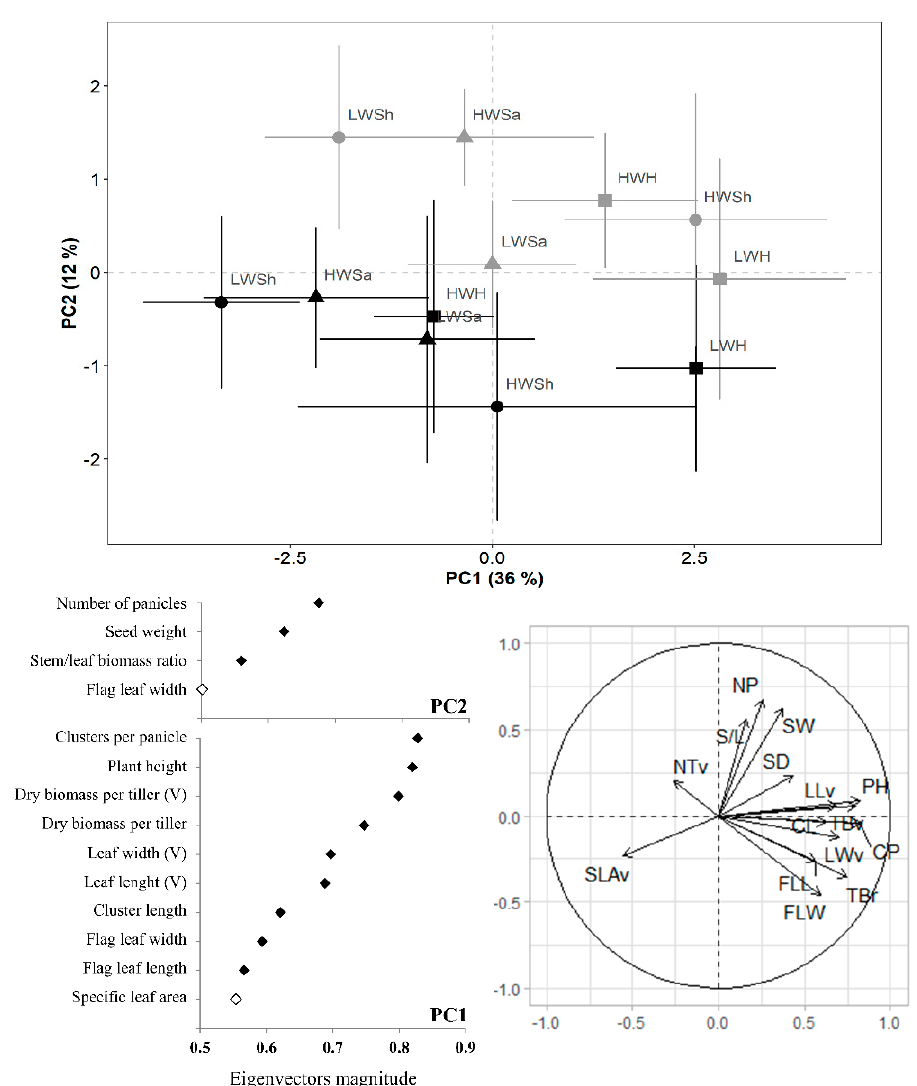
Figure 4. Principal Component Analysis (PCA) of plant functional traits in populations of Leptochloa pluriflora cultivated in two experimental environments: Sumalao (grey symbols) and Esperanza (black symbols) during the 2014–2015 summer season. The ID of populations is composed of seed weight (high/low) and origin of population. HWH: high weight-humid origin. HWSh: high weight-subhumid origin. HWSa: high weight-semiarid origin. LWH: low weight-humid origin. LWSh: low weight-subhumid origin. LWSa: low weight-semiarid origin. PH: Plant height. NP: Number of panicles. S/L: Stem/leaf biomass ratio. TBr: tiller biomass at the reproductive stage. SW: Seed weight. FLL: Flag leaf length. FLW: Flag leaf width. CP: Number of clusters per panicle. CL: Cluster length. NTv: Number of vegetative tillers. TBv: tiller biomass at the vegetative stage. LLv: Leaf length. LWv: Leaf width. SLAv: Specific leaf area.